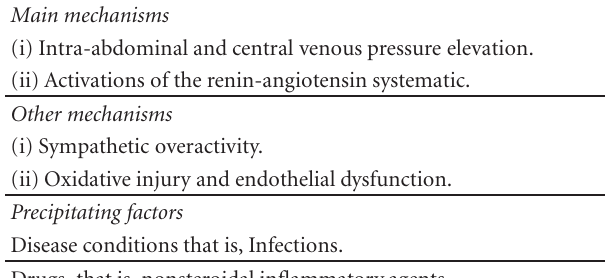
Table 1: Mechanisms thought to be involved in the pathogenesis of the cardiorenal syndrome in HFPEF